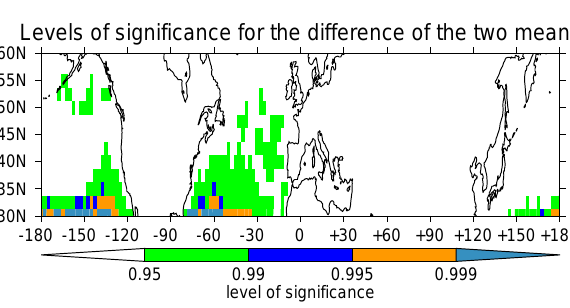
Levels of significance for the difference of the two means